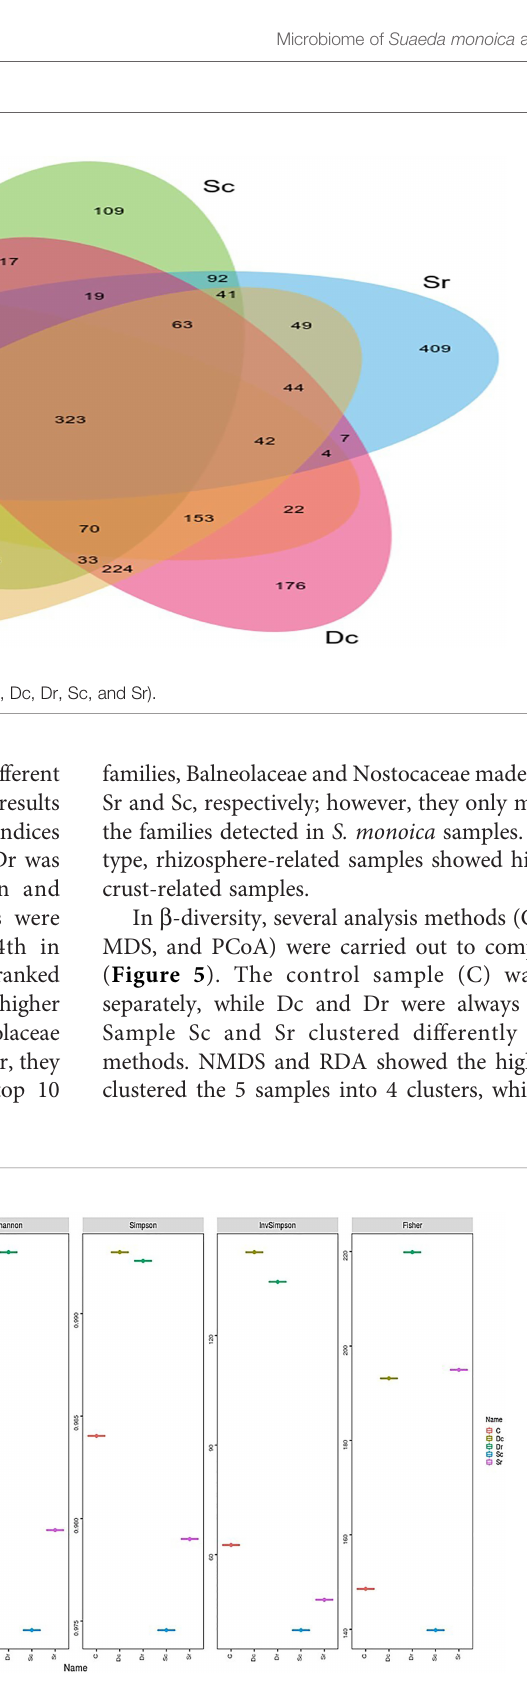
FIGURE 4 | Alpha ( a ) diversity indices of soil samples (C, Dc, Dr, Sc, and Sr).